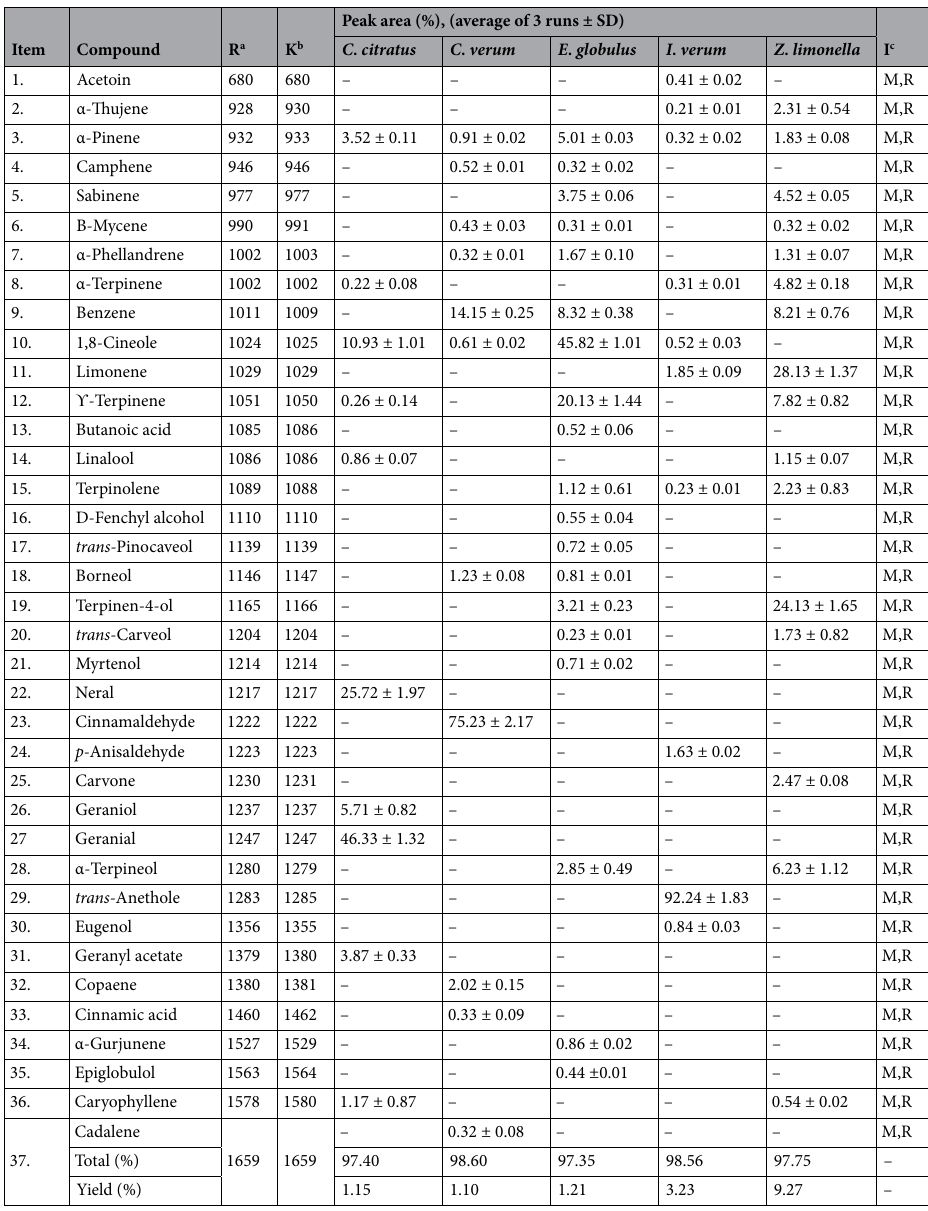
Table 1. Chemical constituents of Cymbopogon citratus , Cinnamomum verum , Eucalyptus globulus , Illicium verum , and Zanthoxylum limonella and their percentage yield in the total chemical profile. a R = Retention index of a chemical constituent determined with an HP-5 MS column and compared with the retention indices of standard alkanes (C and confirmed by mass spectrum (M) matching with chemicals in the computer mass library of Adams 61 and by retention index (R) matching with those reported in NIST17 62